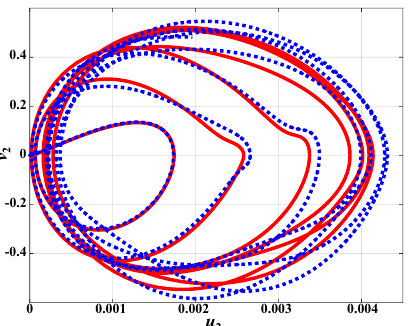
Figure 19. Phase plot at point T : plate model (solid line); beam model (dashed